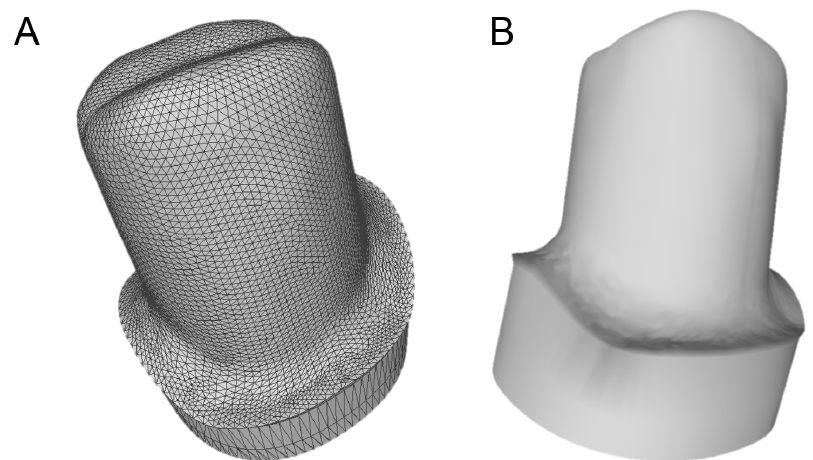
Figure 4. The provisional crown (PLAN1) as visualized in an open ‐ access software (Meshlab ® , Pisa, Italy). ( A ) external view of the mesh; ( B ) internal view of the mesh with the margin line clearly visible (in implantology, the margin line is designed on a library file, and not on a mesh, therefore it is perfect).